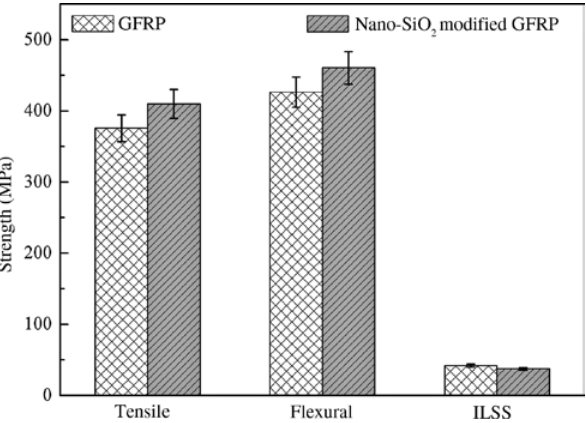
on the mechanical properties of the 2